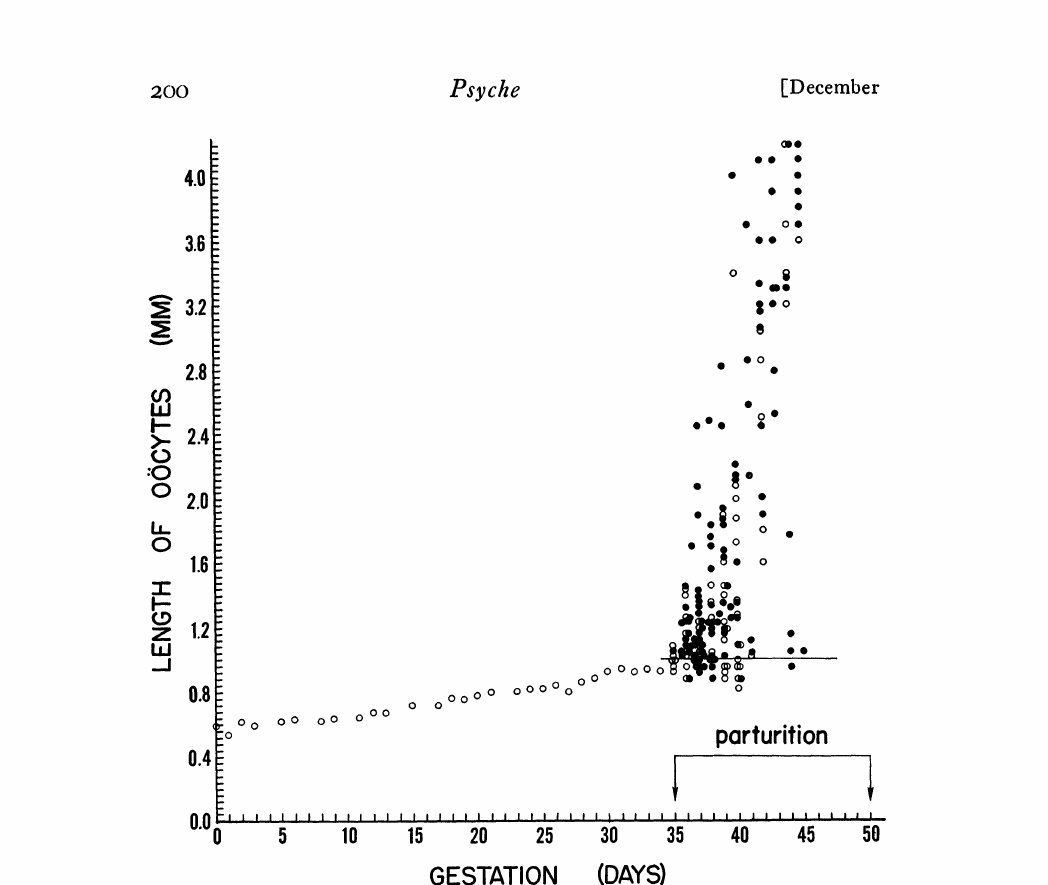
Fig. 1. O6cyte development during pregnancy in N. cinerea. All points from 0-3a days are mean values of 5- 9 individuals (N 197); standard errors are not indicated but were +/- 0.04 mm. or less for all of these measurements. Each point beyond 35 days of pregnancy represents the oticytes of one female. Open circles females were still carrying oSthecae when dissected. Solid circles females dissected at the time of parturition or within 24 hr. after giving birth. The horizontal line is drawn at mm. which is about the minimum size of the o/Scytes that contain